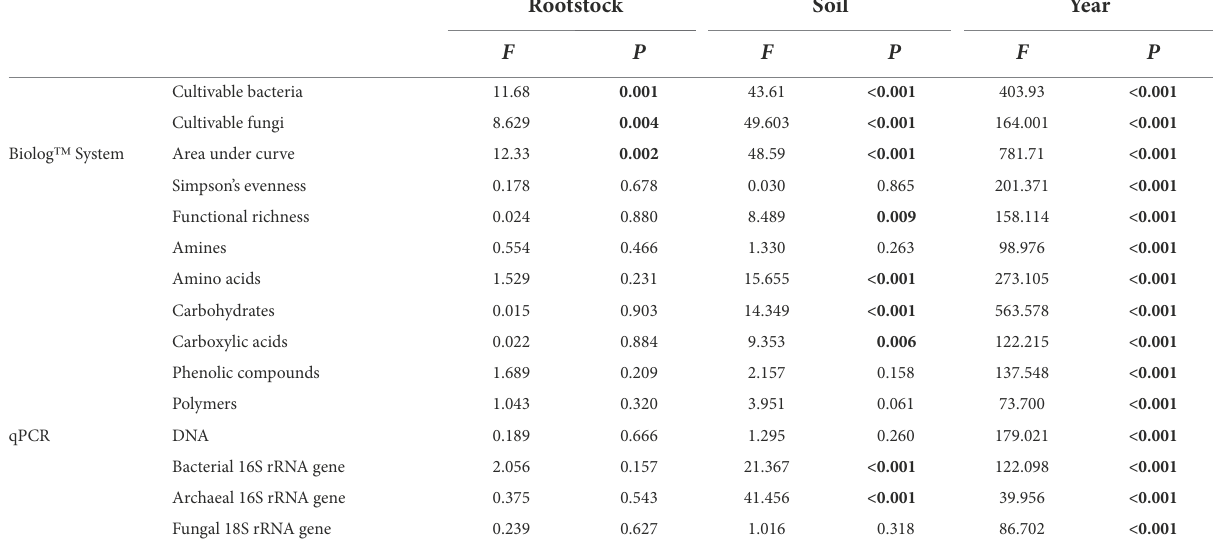
TABLE 3 Effect of soil type (S, AS), rootstock genotype (1103P, RGM) and year of the experiment (2019, 2020) on the rhizosphere microbial